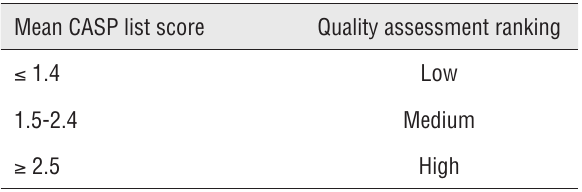
Table 5 – Overall quality ranking allocation of each study based on mean CASP score